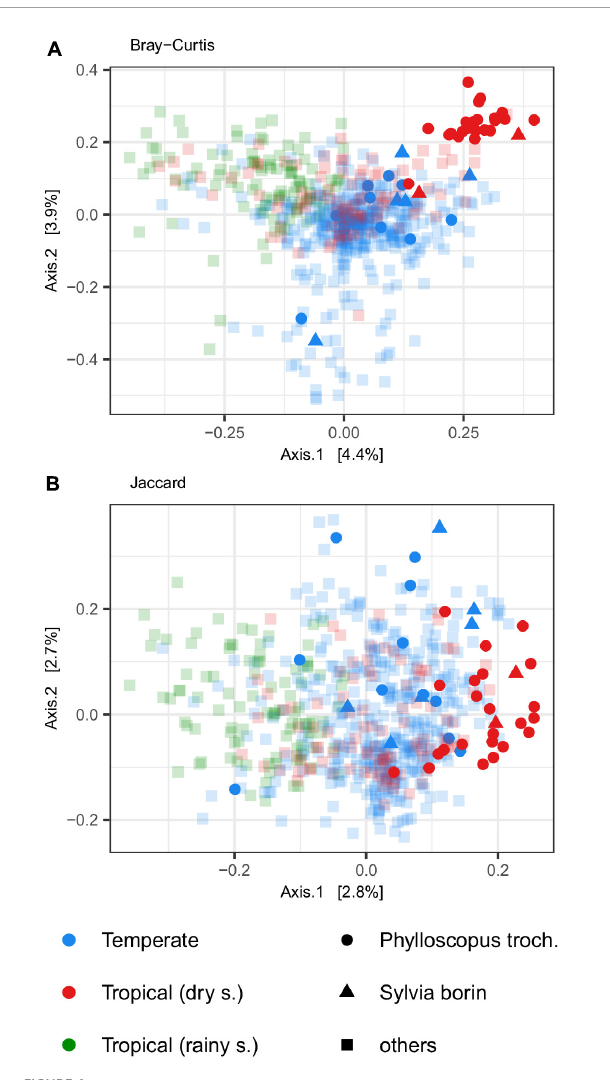
FIGURE4 Principal coordinate analysis (PCoA) for (A) Bray-Curtis and (B) Jaccard dissimilarities depicting gut microbiota (GM) changes between two trans-Saharan species (willow warbler– Phylloscopus trochilus and garden warbler– Sylvia borin ; in opaque colors) that were collected in temperate zone during the breeding period (blue) or tropical zone during the migration and wintering period (red). Samples from other species are indicated by semitransparent